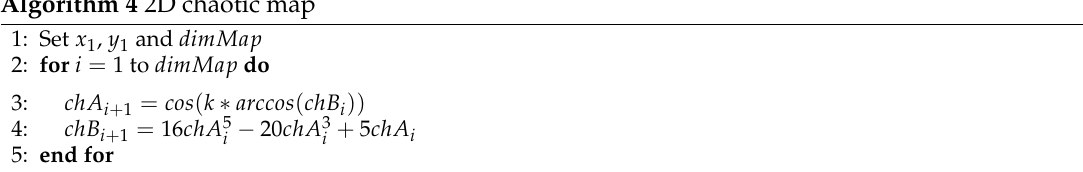
Algorithm 4 2D chaotic